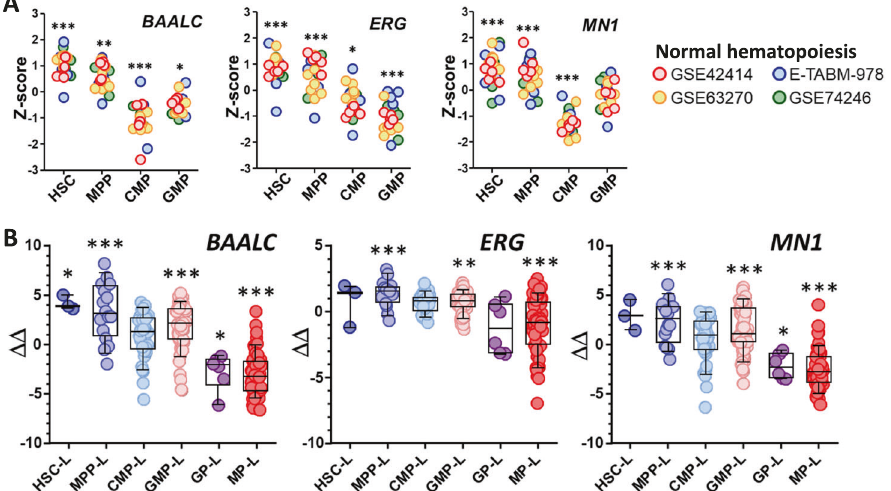
Fig. 2 Genetic validation of SLA classi fi cation. A Expression of BAALC , ERG , and MN1 in four normal HSPCs datasets. Gene expressions were normalized calculating Z -score in each dataset. B Expression of BAALC , ERG , and MN1 according to SLA subgroups in TUH cohort ( fl uidigm, n =